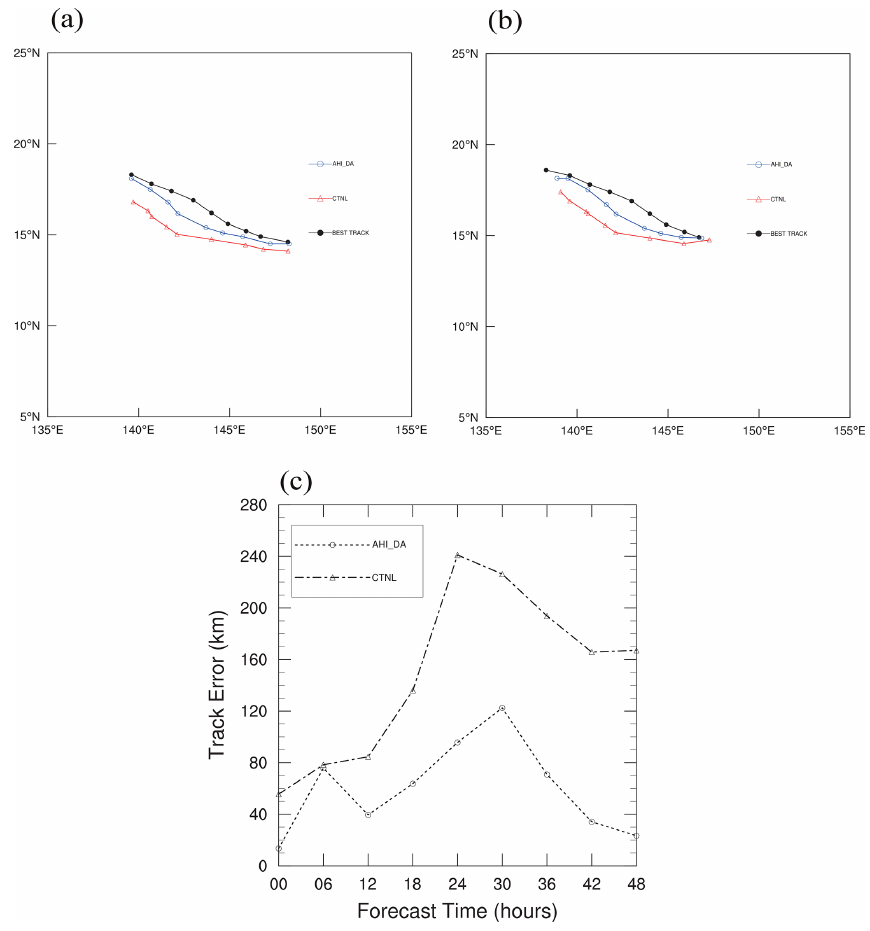
Figure 12. The 48h predicted tracks (a) from 00:00UTC on 2 August to 00:00UTC on 4 August and (b) from 06:00UTC on 2 August to 06:00UTC on 4 August 2015; (c) averaged track errors (unit: km) for the two forecasts.